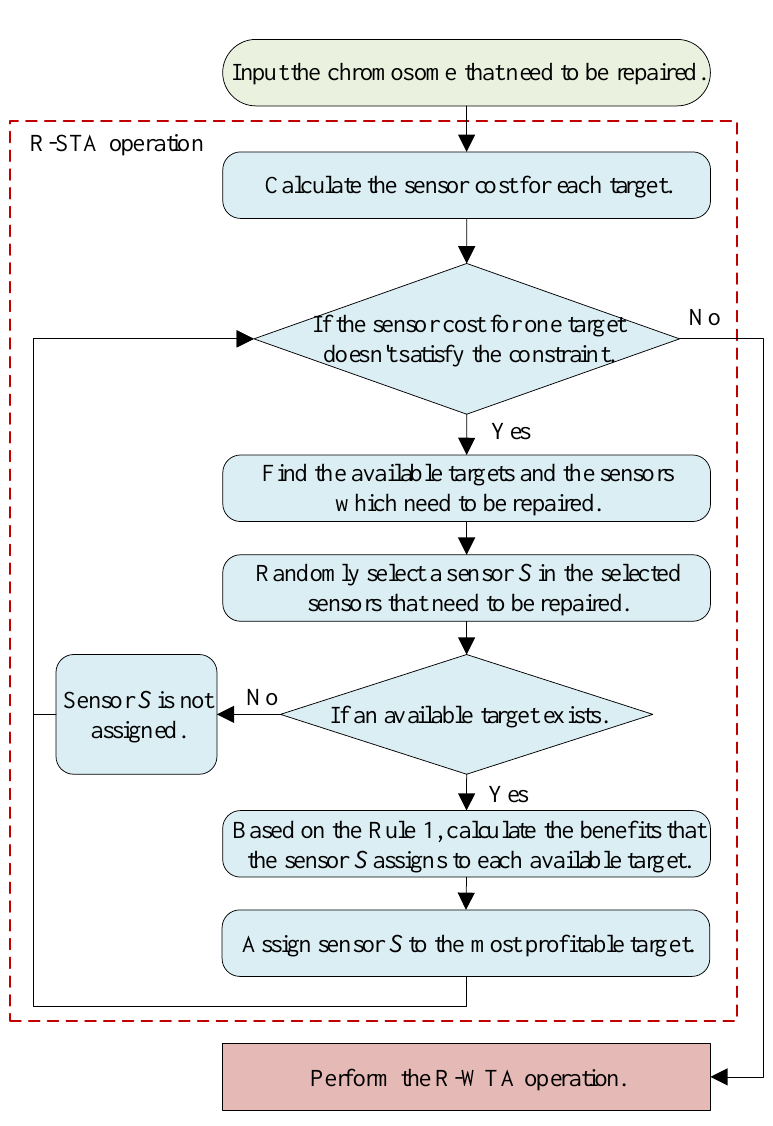
Figure 9. The flow chart of the R-STA